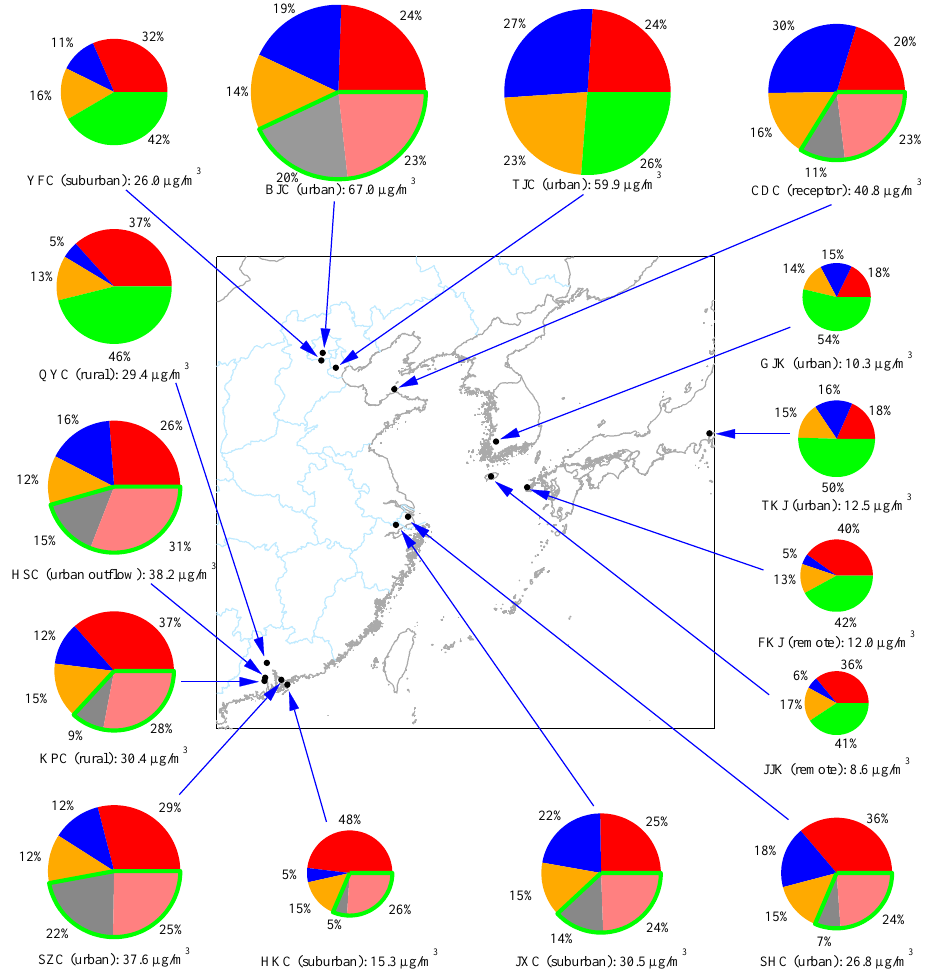
Figure 2. Summary of AMS-measured NR-PM 1 compositions in Asia. The green slices represent total organics. Within the green outlines are organics with PMF-resolved factors. The grey slices within the green outlines are the sum of all POA with one or more factors of HOA, COA, BBOA, and CCOA (coal combustion). The light red slices within the green outlines are the sum of all OOAs with one or more factors of SVOOA and LVOOA. The area of a pie chart is proportional to the NR-PM 1 concentration. See Table S2 in the Supplement for the site locations.